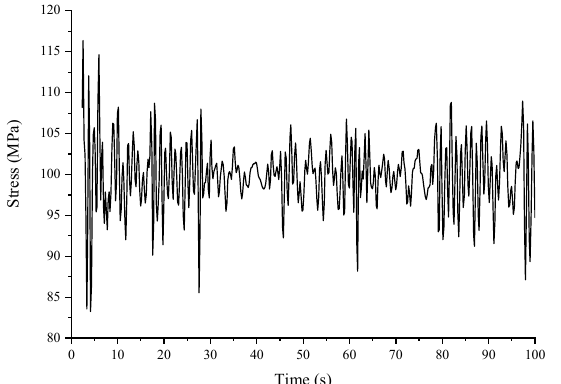
Figure 23. Stress at the hot spot under RIC (ice thickness was 0.32 m and ice velocity was 0.63 m·s − 1 ).